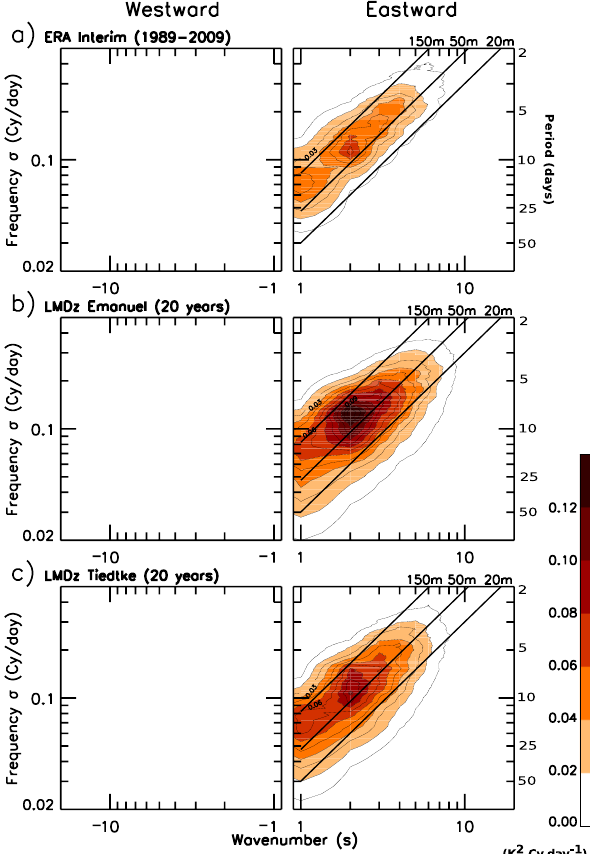
Fig. 4. Wave-number–frequency spectra of the temperature aver- aged over latitude range from 10 ◦ S and 10 ◦ N, at 50hPa (units are in K 2 Cyj − 1 ): (a) ERAI, (b) LMDz-E and (c) LMDz-T. Contour in- tervals are 0.02K 2 Cyj − 1 for the shaded areas and 0.01K 2 Cyj − 1 for the thin solid lines. The light (dark) colours show relatively low (high) spectrum values for the temperature. The dispersion curves (thick solid lines) from Eq. (3) are calculated for KWs ( ν = − 1) with h = 20 , 50 and 150m.